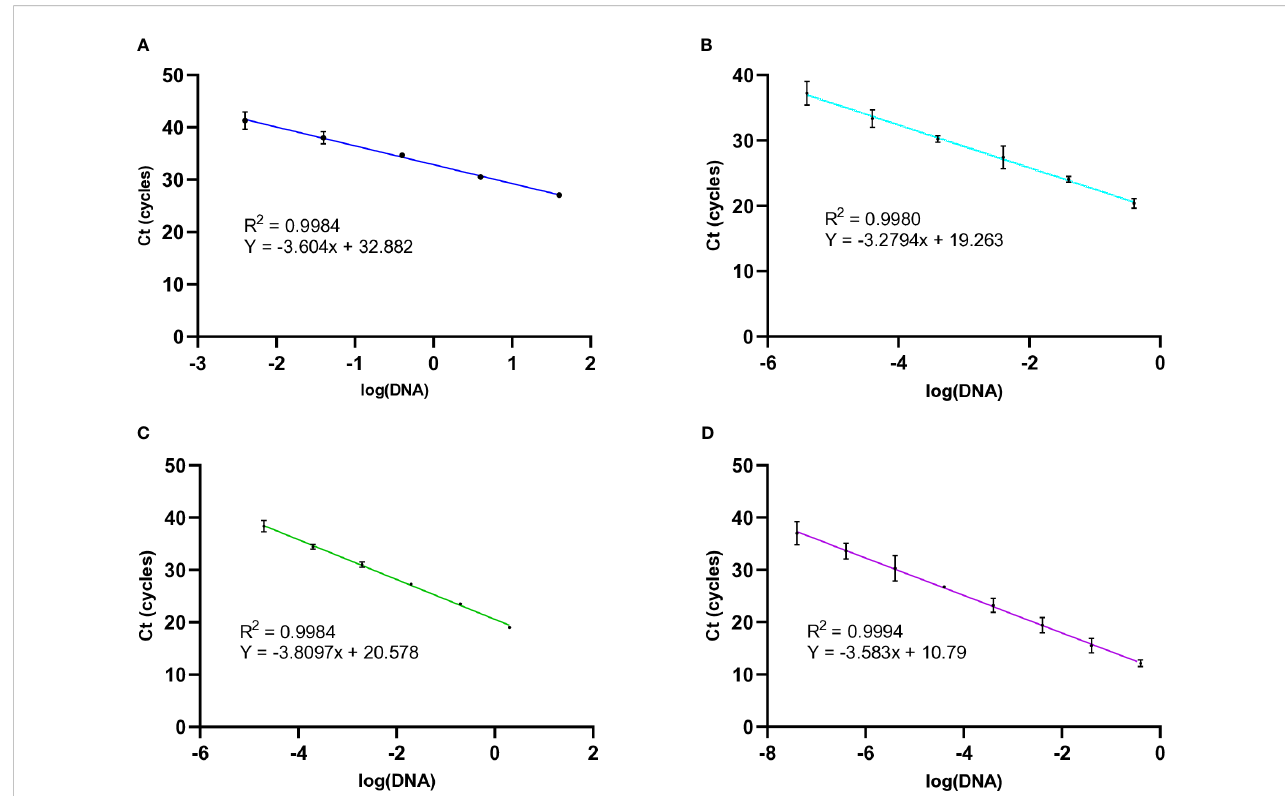
FIGURE 3 Standard curves of known concentrations of templates from M. chitwoodi, M, fallax , and M. minor with 95% con fi dence intervals (A) The relationship between Ct values and the natural log of M. chitwoodi race 1 gDNA from 40 ng to 4 pg (n = 3). (B) M. chitwoodi HSP90 plasmid DNA template from 2 ng to 20 fg (n = 3). (C) M. fallax HSP90 plasmid DNA template from 0.2 ng to 20 fg (n = 2). (D) M. minor HSP90 plasmid DNA template from 0.4 ng to 0.04 fg (n =